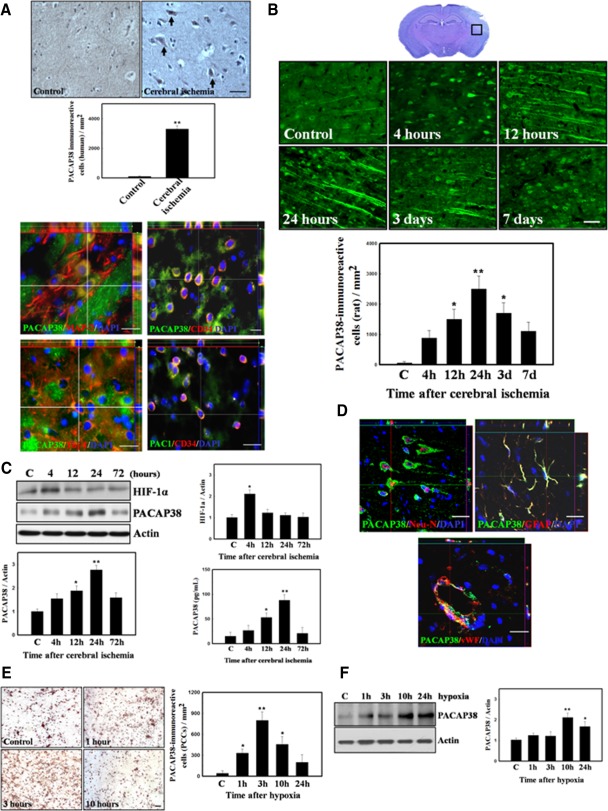
Hypoxia/ischemia-induced upregulation of PACAP38 expression in human and rat brain and PCCs. (A): Representative figures from patients 1 and 3 days after a stroke onset (upper panel). In immunohistochemical analysis of the penumbral area for PACAP38 (black arrows), quantitative measurement showed significantly increased numbers of PACAP38+ cells in the brains of patients after cerebral infarction as compared with controls. By 3D image, MAP-2+ and Tuj-1+ neuronal cells were costained with PACAP38 (left lower panel). In addition, some PACAP38+CD34+ and PAC1+CD34+ cells were dispersed over the penumbric region (right lower panel). (B): The square (□) indicates the representative area of cerebral ischemia for which immunoreactivity for PACAP38 is shown. These areas include the penumbral and perivascular regions, which were examined at different time points (4, 12, and 24 hours and 3 and 7 days) after cerebral ischemia. Quantitative analysis of PACAP38 immunoreactivity over time is shown (C, control). (C): Western blot analysis of HIF-1α and PACAP38 expression for ischemic brain, data from Western blots was quantified and is shown with respect to control expression. Quantitative data from ELISA of PACAP38 are shown. (D): Double immunofluorescence (3D images) showed that cells expressing PACAP38 in the penumbra area colocalized with the specific markers Neu-N, GFAP, and vWF. (E): Immunohistochemistry of PCCs for PACAP38 under hypoxic conditions, quantitative data from PACAP38+ cells are shown. (F): Western blotting for PACAP38 expression in PCCs after hypoxia treatment, quantitative data from western blots are shown. The mean ± SEM is shown. *, p < .05 and **, p < .01 vs. control. Scale bar = 50 μm. Abbreviations: DAPI, 4′,6-diamidino-2-phenylindole dihydrochloride; GFAP, glial fibrillary acidic protein; HIF-1α, hypoxia-inducible factor-1α; MAP-2, microtubular associated protein-2; Neu-N, neuronal nuclear; PACAP38, pituitary adenylate cyclase-activating peptide 38; PAC1, PACAP type 1 receptor; PCC, primary cortical culture; Tuj-1, βIII-tubulin; vWF, Von Willebrand factor.